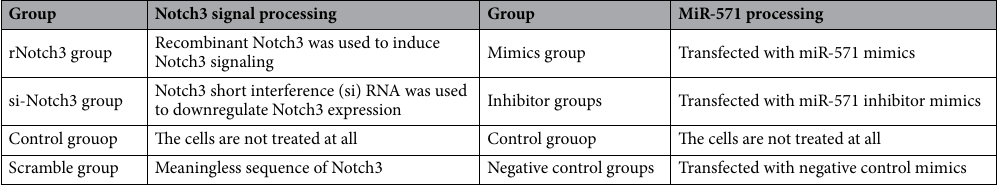
Table 1. Different treatments of LX-2